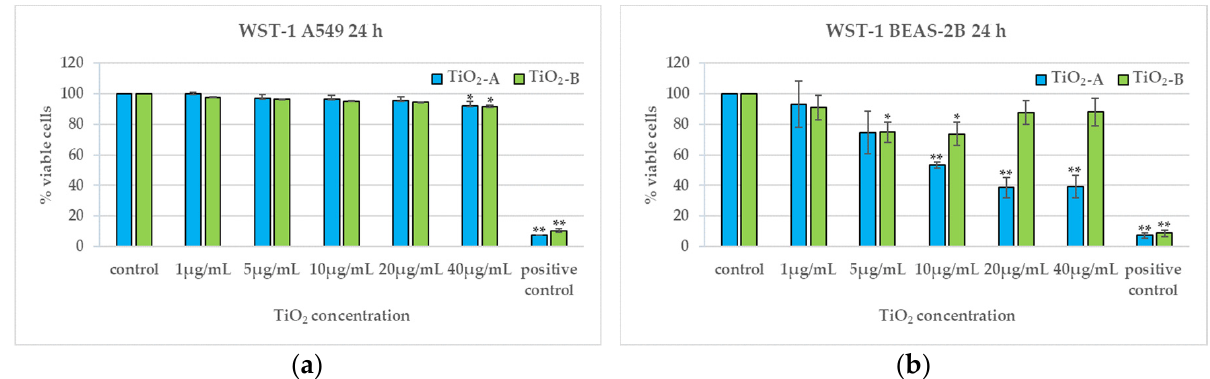
Figure 3. Viability percentage of A549 ( a ) and BEAS-2B ( b ) cells after 24 h exposure to TiO 2 NPs evaluated by the WST-1 assay. * p ≤ 0.05, ** p < 0.01. Data relative to TiO 2 -A are previously published in [10] (Reproduced with permission from [10]. Copyright John Wiley & Sons, Ltd.,